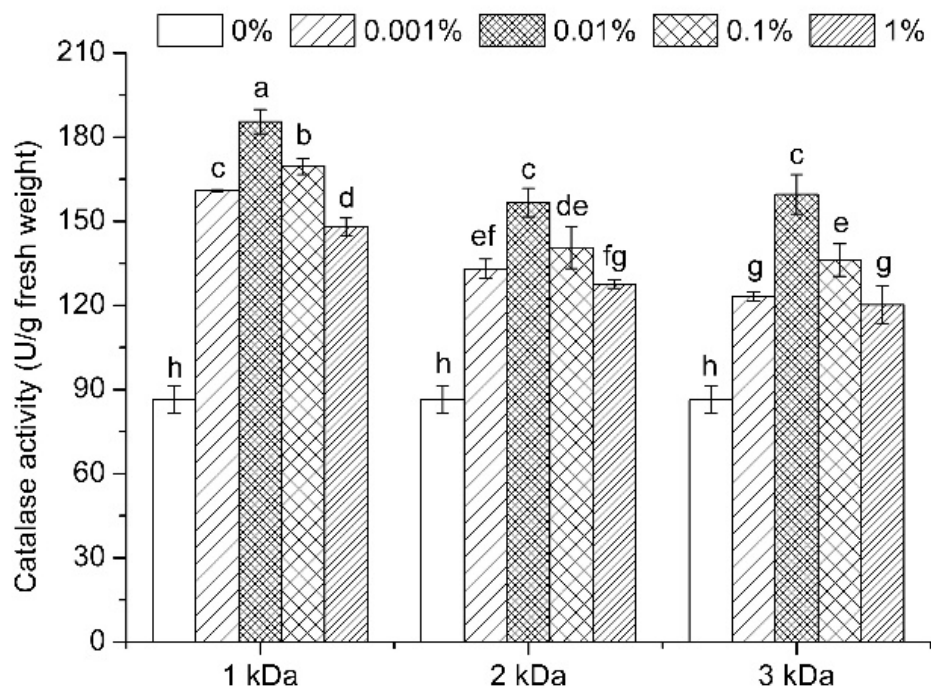
Figure 6. Catalase activity of soybean sprouts under different chitooligosaccharide treatments. The treatments were conducted with chitooligosaccharides of three molecular weights (1, 2, and 3 kDa) at four different concentrations (0.001 to 1%). The control treatment (0%) included the same solutions without chitooligosaccharides. Vertical bars represent the standard error of three replicates. Different letters indicate statistically significant difference ( p < 0.05).